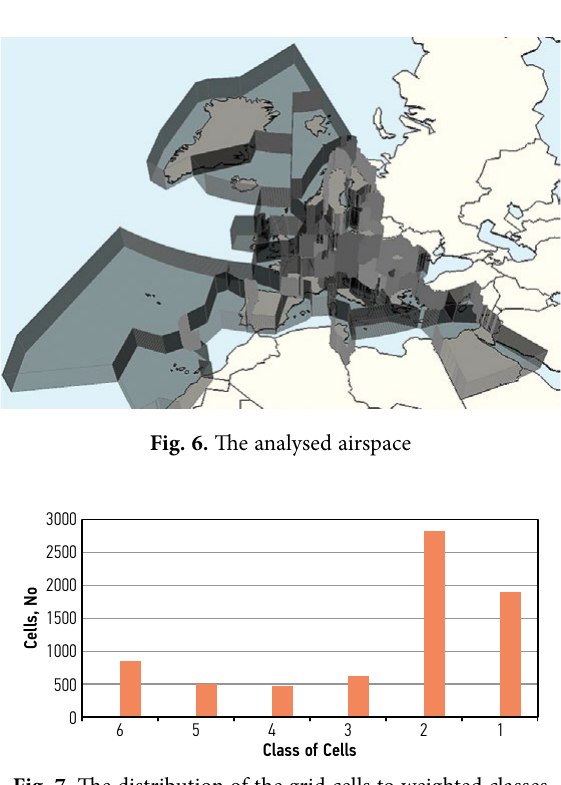
Fig. 7. The distribution of the grid cells to weighted classes